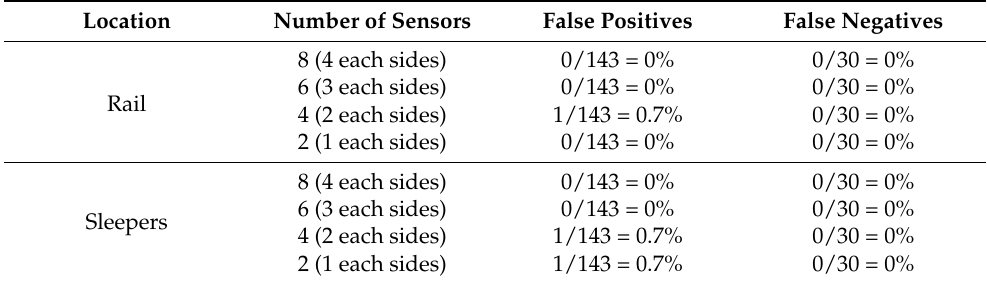
Table 4. False detections concerning the number of sensors installed in the rail/sleepers with the CWT technique.